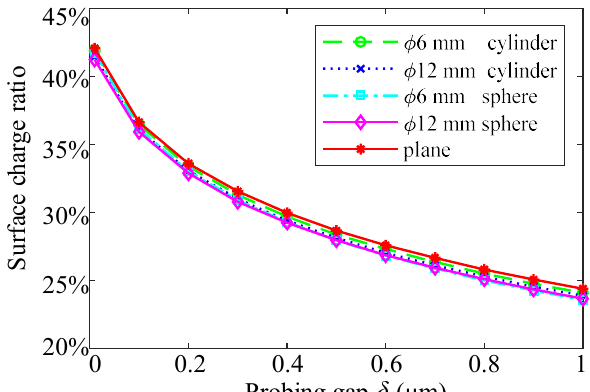
Figure 10. Surface charge ratio as a function of probing gaps on surfaces of different geometries (surface area ratio = 1%).